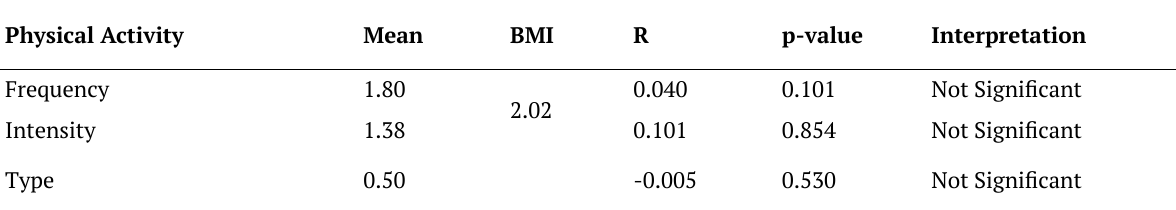
Table 6. Relationship between respondents’ physical activity and